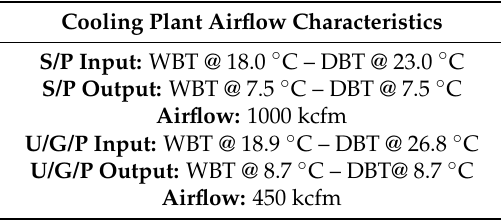
Table 4. Operational characteristics of cooling